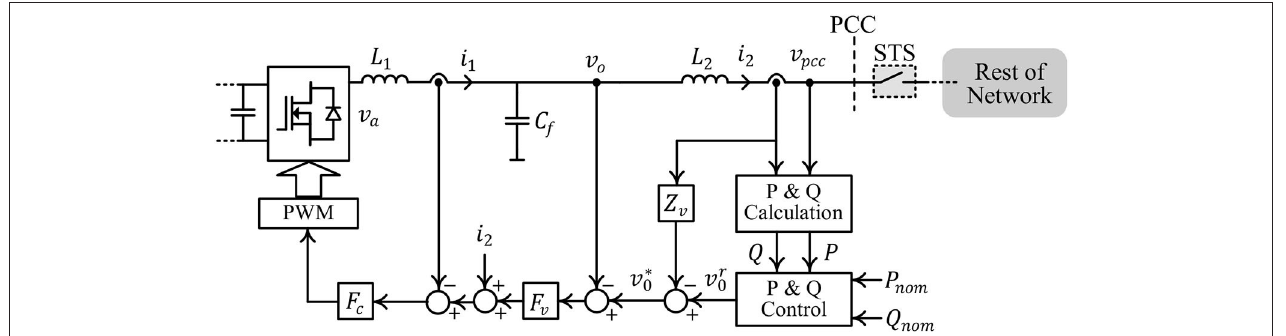
FIGURE 1 | Typical control structure for a GFM converter based on droop control.